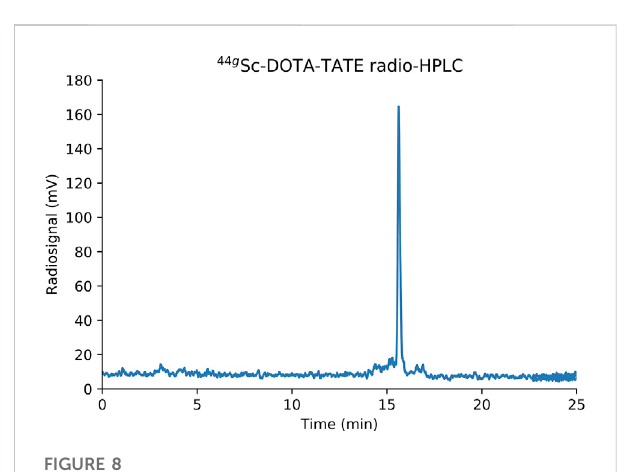
FIGURE 8 Radio-HPLC chromatogram of 44g Sc-DOTA-TATE.